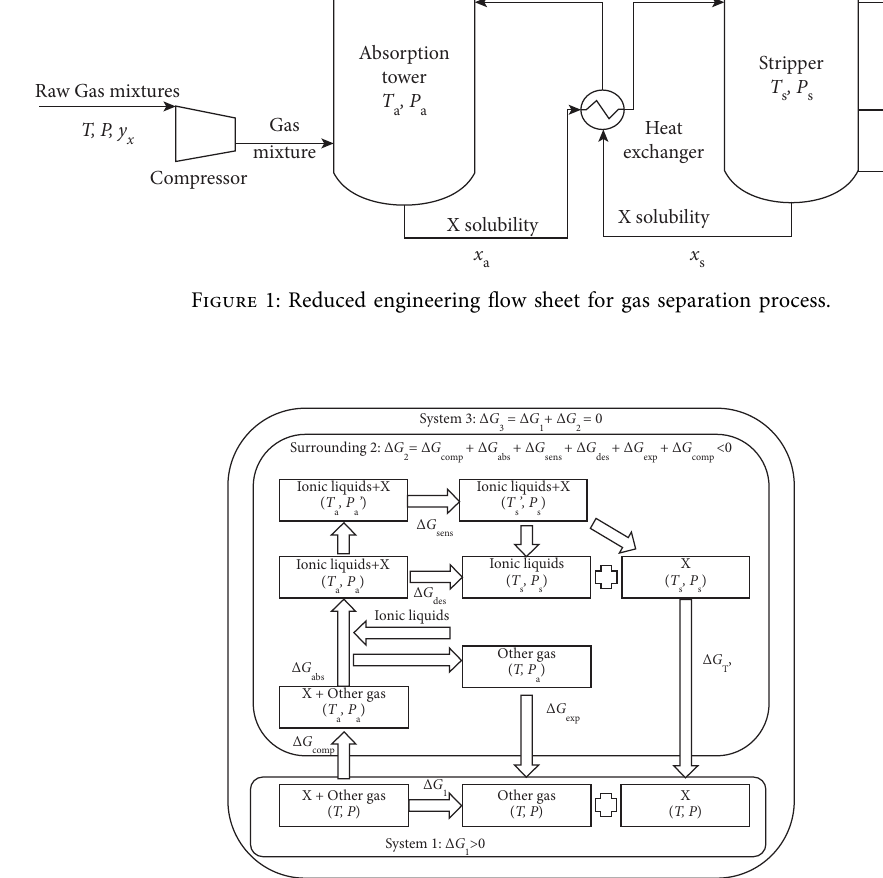
Figure 2: Te thermodynamic analysis of the coupling process of gas separation with